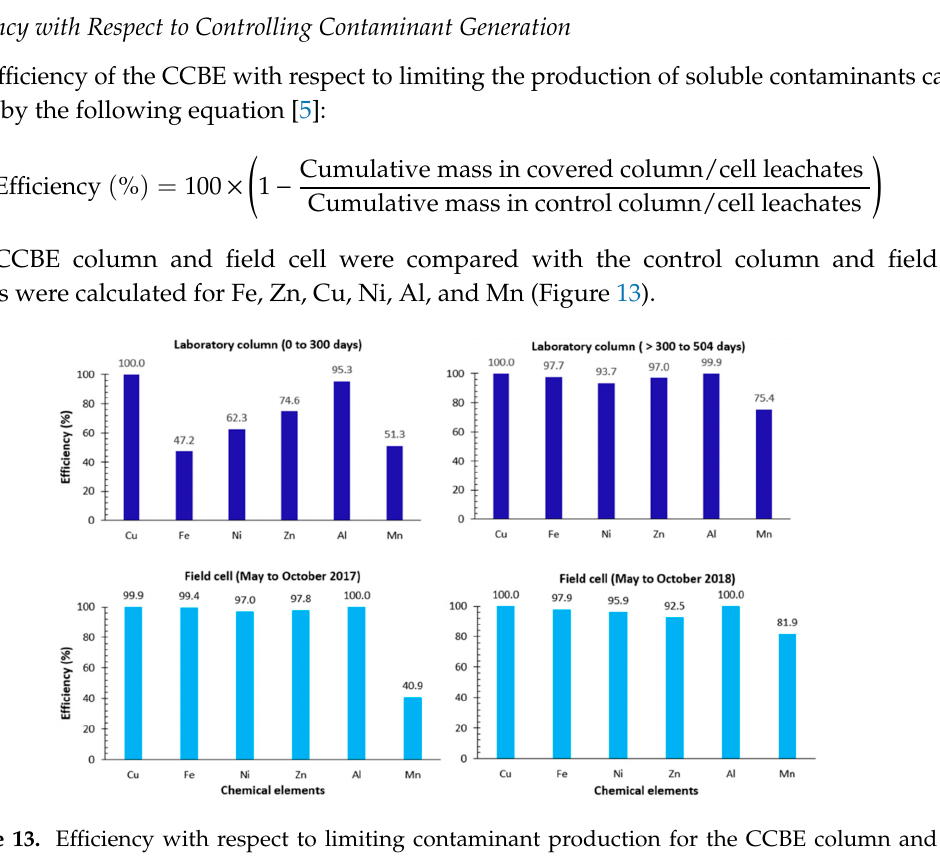
Figure 12. Oxygen fluxes calculated using the sulfate release method for CCBE column and CCBE field cell.